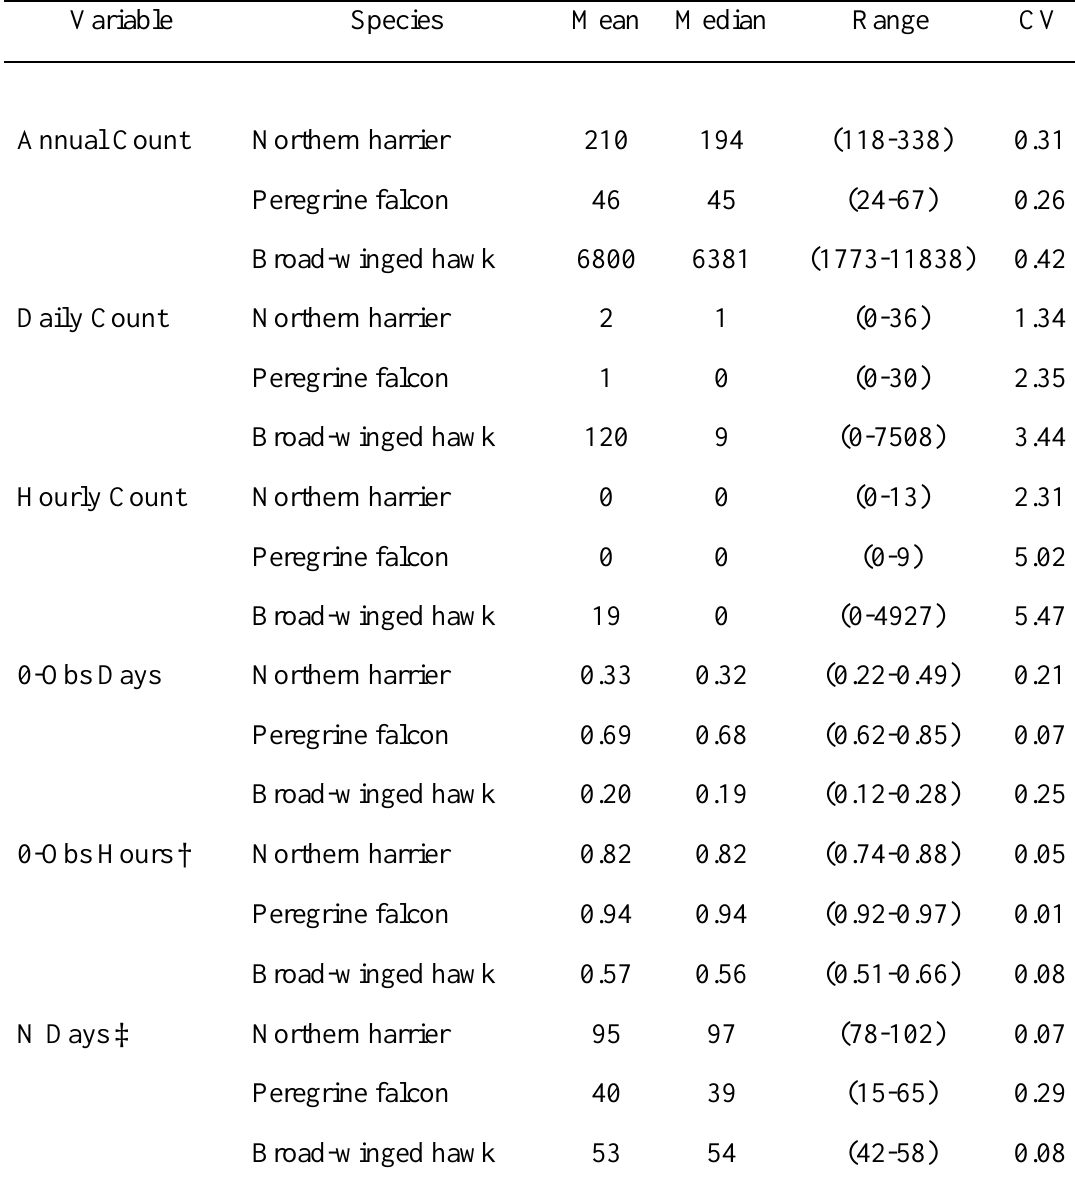
Table A1.1. Mean, median, range and coefficient of variation (CV) for annual, daily and hourly counts, proportion of 0-observation days and hours ('0-Obs Days', '0-Obs Hours'), and number of days between first and last detection ('N Days') for three raptor species detected at Hawk Mountain Sanctuary, Pennsylvania (1991-2010). Values were used as a guide to simulate data with a similar distribution of